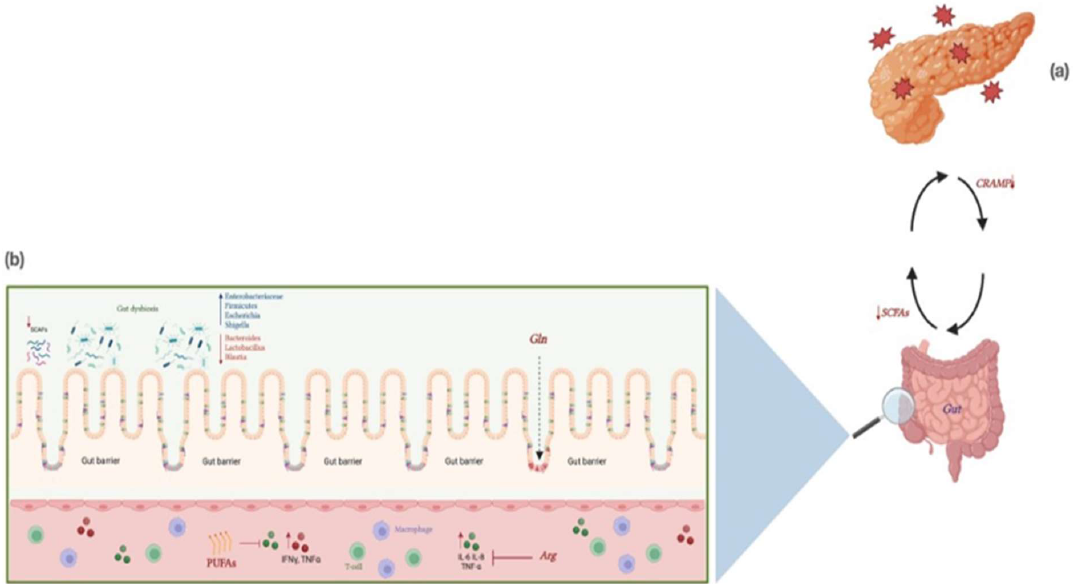
Figure 1. Gut–pancreas axis during AP. ( a ) During AP, we observe a reduction in AMPs production by the pancreas. This facilitates bacterial overgrowth and the release of inflammatory cytokines such as TNF-α, IL-1, IL-6, IL-8, and IFN-γ. At the same time, intestinal dysbiosis is associated with a reduction in the production of SCFAs, resulting in increased intestinal permeability and worsening pancreatic damage. ( b ) Immunonutrients modify the inflammatory response that occurs during AP, and act on the damaged intestinal barrier. SCFAs: short-chain fatty acids; AMPs: antimicrobial peptides; TNF- α : tumor necrosis factor- α ; IL-1: interleukin-1; IL-6: interleukin-6; IL-8: interleukin-8; IFN-γ; Interferon-gamma; Arg: arginine; Gln: glutamine; PUFAs: omega-3-unsatured fat acids. Created with BioRender.com.